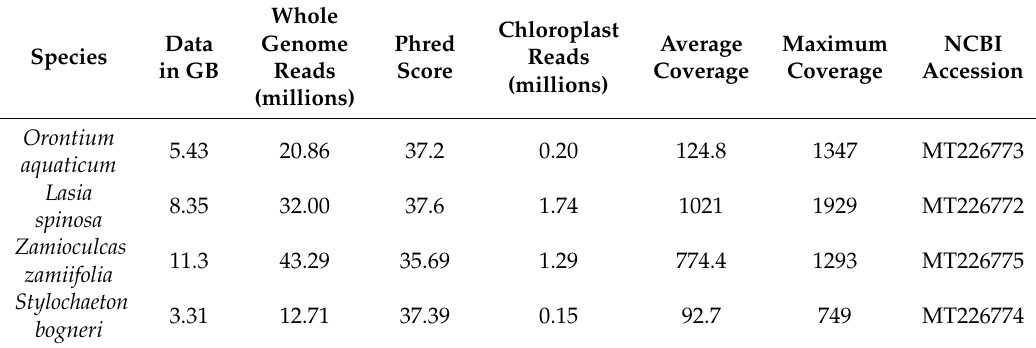
Table 1. Quality and quantity of whole genome short reads and coverage depth analyses of de novo assembled